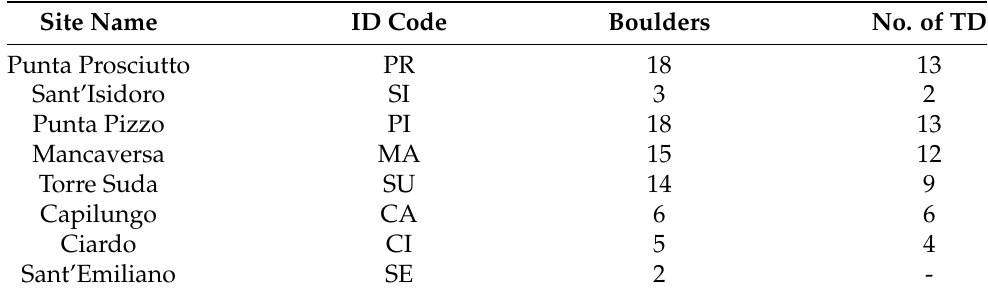
Table 1. Acronym code (ID Code), number of identified Boulders, and number of measured Transport Distances (No. of TD).